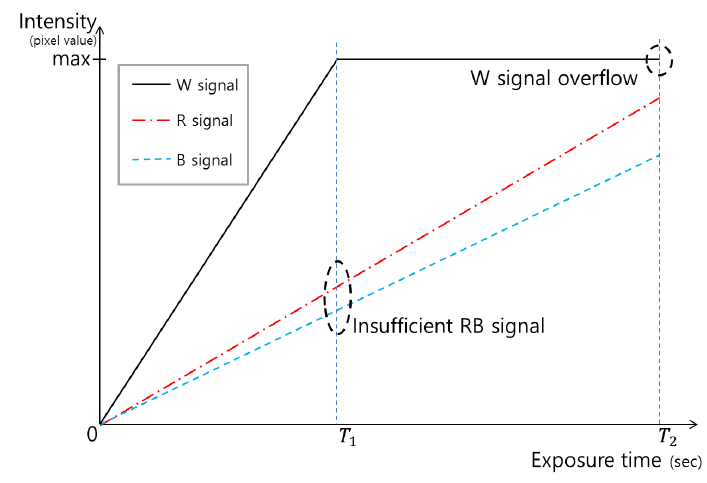
Figure 2. Intensity variation with exposure time for R, B, W signals with the RWB CFA image